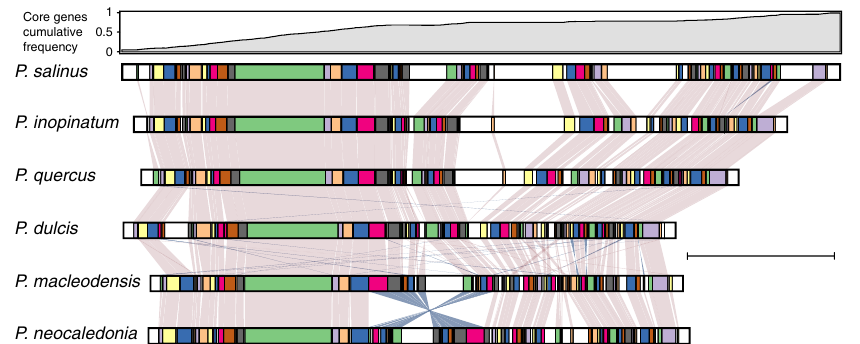
Fig. 4 Collinearity of the available pandoravirus genomes. Cumulative frequency of core genes is shown at the top. Conserved collinear blocks are colored in the same color in all viruses. White blocks correspond to non-conserved DNA segments (scale bar is 500 kb)